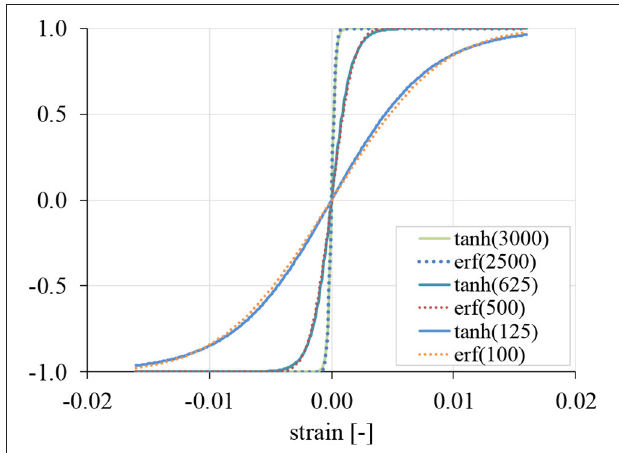
FIGURE 4 | Comparison of the error and hyperbolic tangent functions.